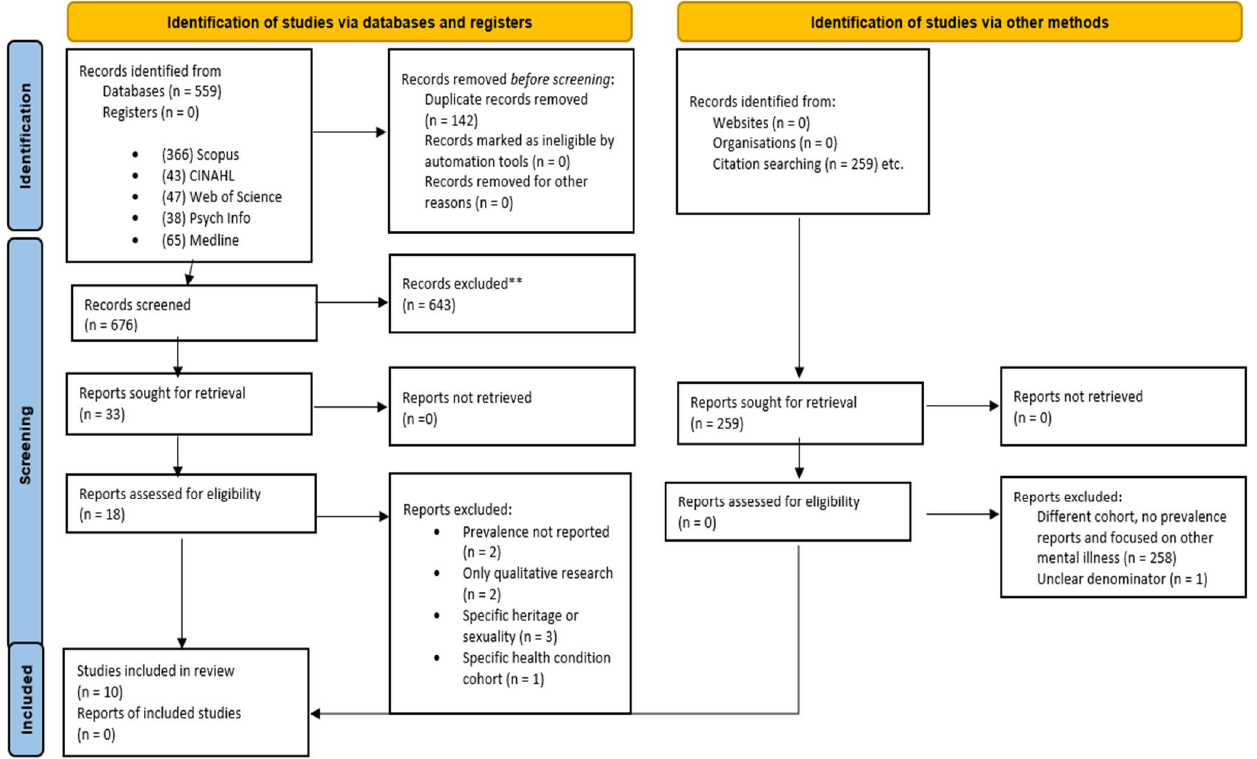
Figure 1. PRISMA flowchart (2020).